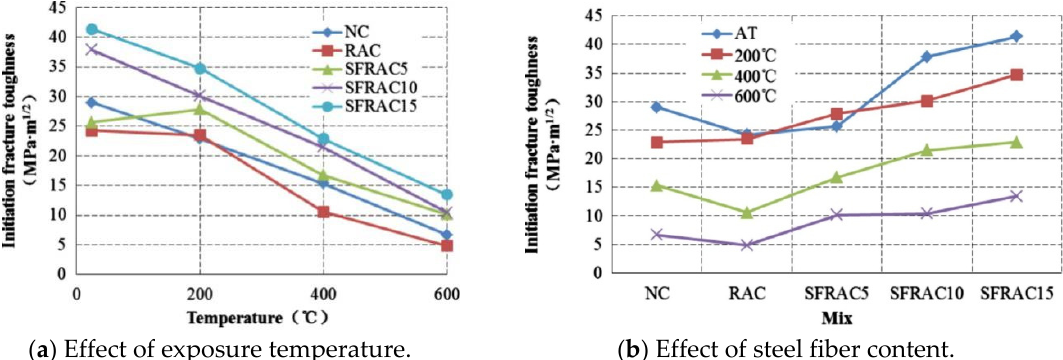
Figure 7. Effects of exposure temperature and steel fiber content on initiation fracture toughness [13].